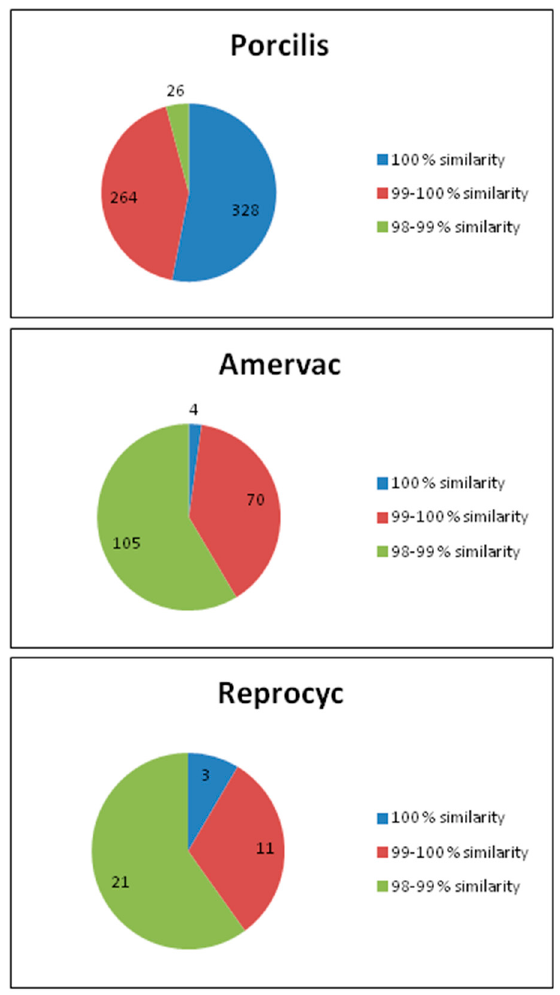
Figure 1. Distribution and sequence similarity of vaccine-related ORF5 sequences.